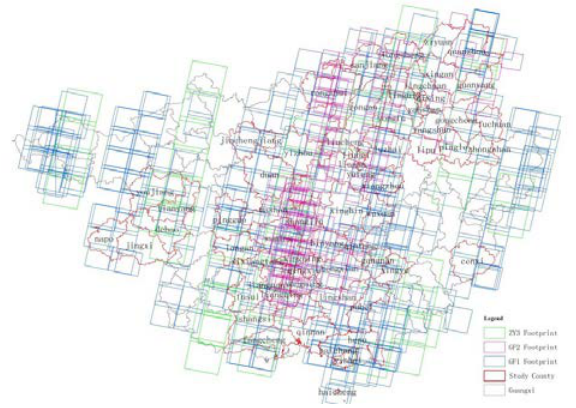
Figure 4. ZY3, GF1, and GF2 footprint in study area in 2016